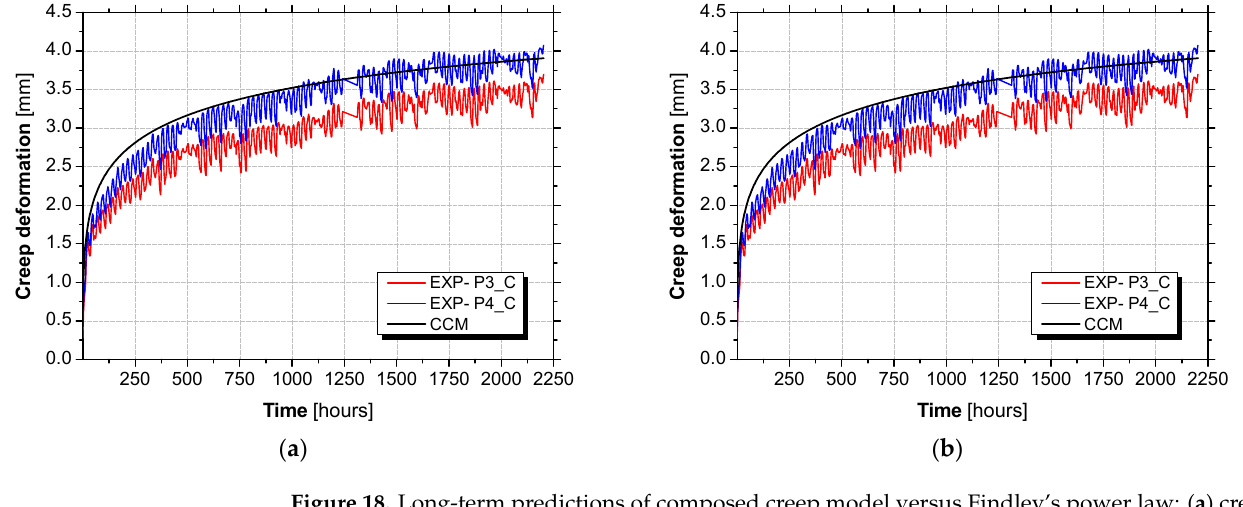
Figure 17. Composed creep model versus experimental results: ( a ) creep deformation and ( b ) total deformation.